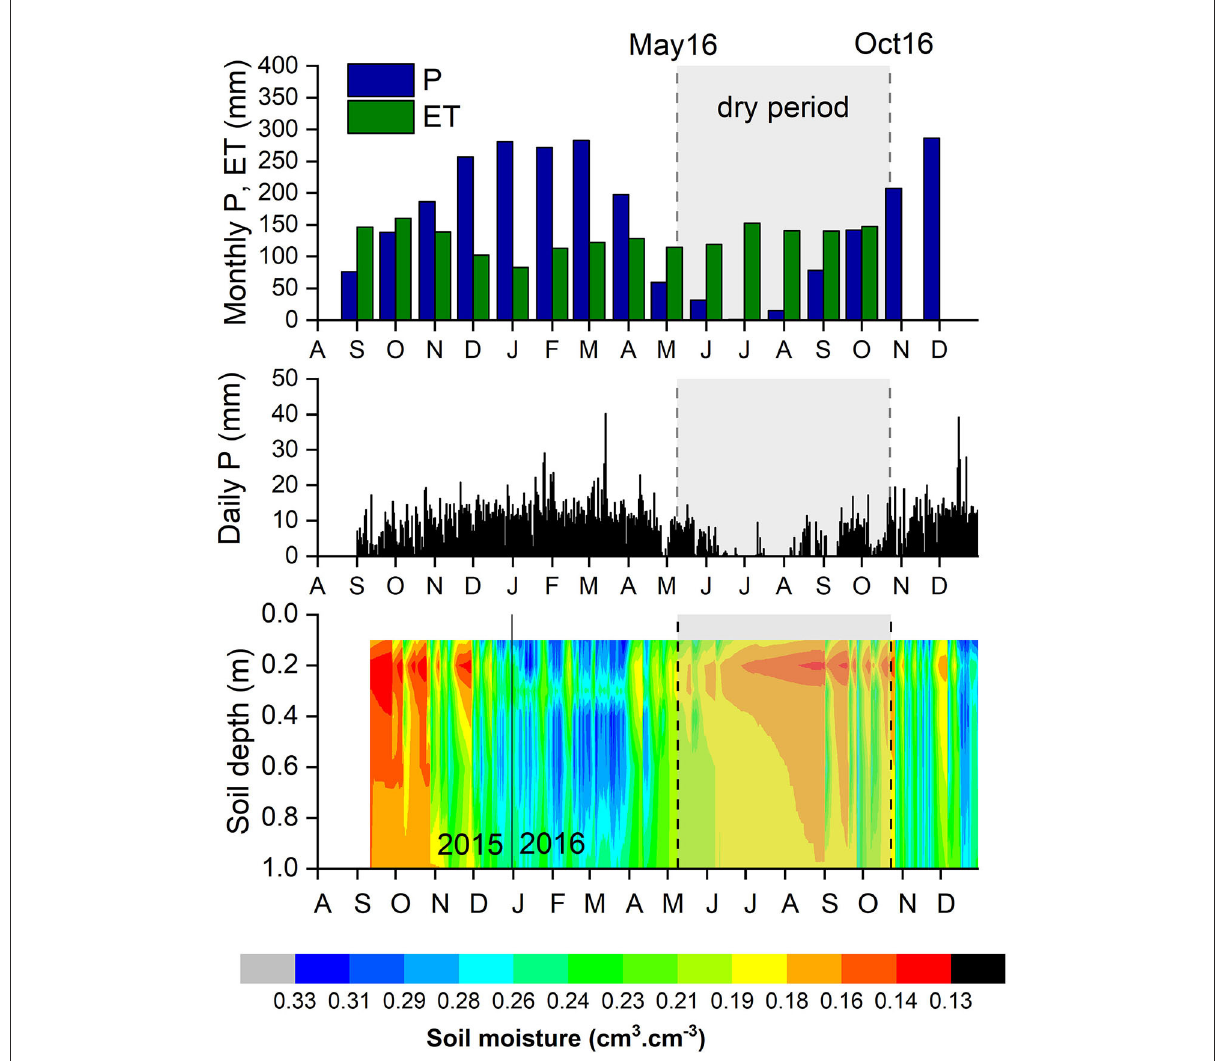
FIGURE1 Environmental conditions in the study area from September 2015 to December 2016. (A) Averaged monthly precipitation (P, mm; blue bars) and ET rates (mm; green bars). (B) Daily precipitation rates (mm), and (C) soil water content ( θ , cm 3 cm − 3 ) at the upper meter of the soil profile. ET data from MODIS (MOD16A2; Souza et al., 2022); monthly and daily P, and θ obtained from the LBA data from the Rebio Jaru EC flux tower.